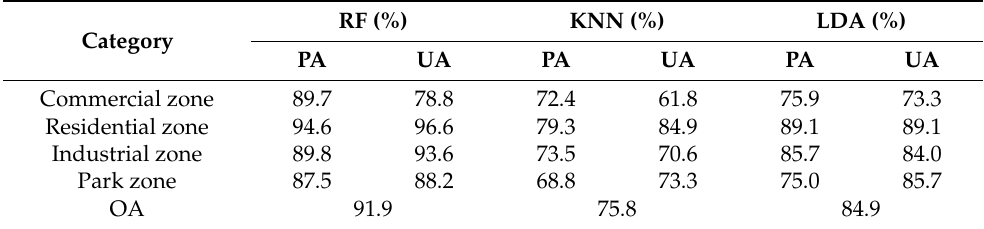
Table 8. A comparison of using RF, KNN, and LDA algorithms in UFZ mapping.